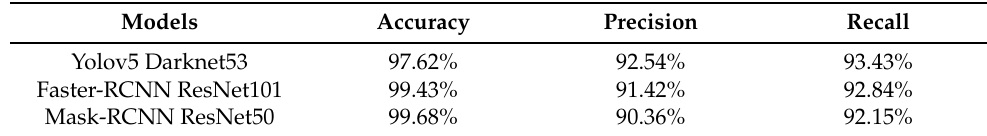
Table 2. Performances of Yolov5, Faster-RCNN and Mask-RCNN for the detection of insect pests based on IP102